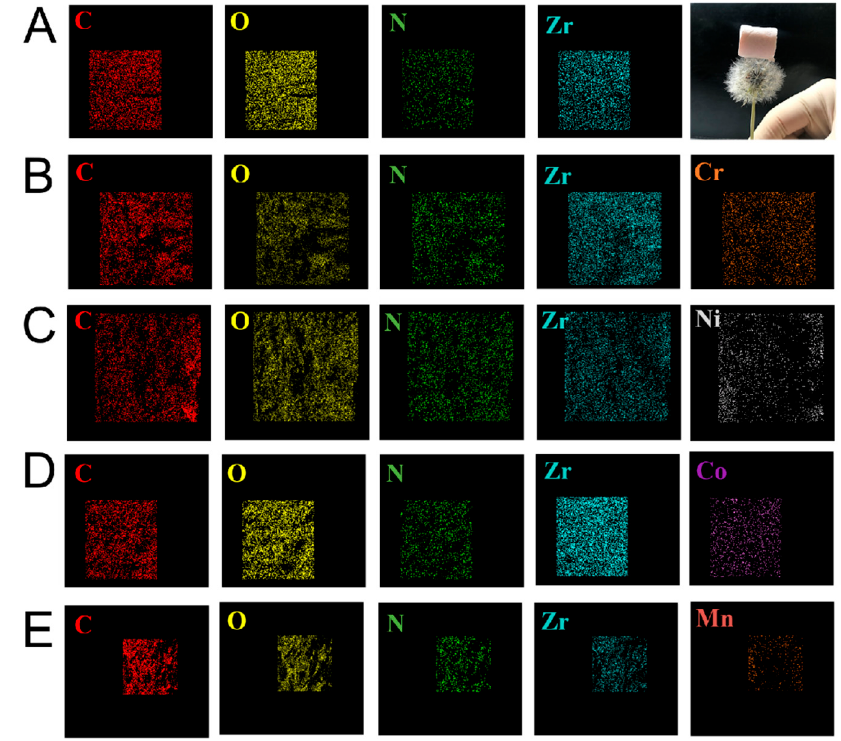
Figure 6. ( A ) Corresponding elemental maps for U -EDTA CCA. ( B – E ) single-metal system U -EDTA CCA loaded with Cr 3+ , Ni 2+ , Co 2+ , and Mn 2+ , respectively.